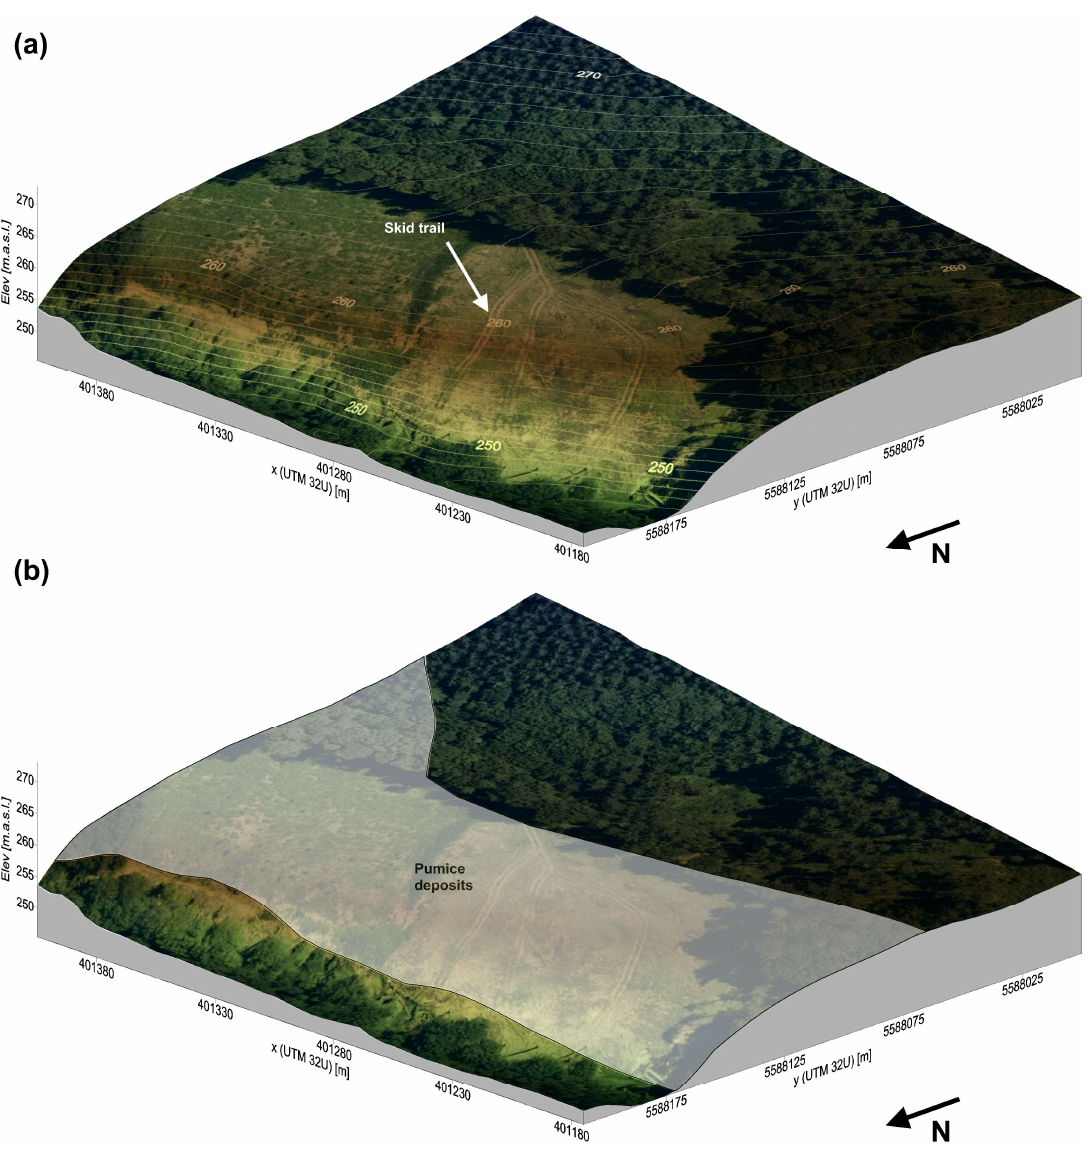
Figure 2. ( a ) Aerial view of the study site, sampled skid trail indicated by arrow; ( b ) pumice deposits according to Geological State O ffi ce of Rhineland-Palatinate (LGB RLP)